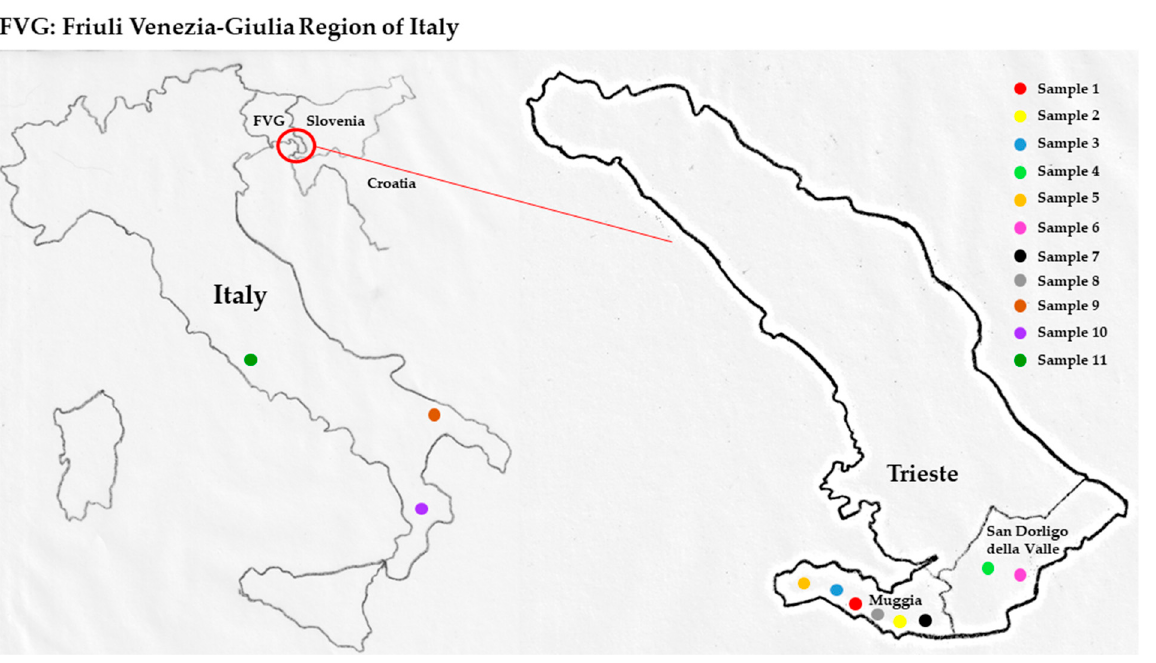
Figure 12. Olive oil samples’ geographical distribution. Table 4. Concentrations of compounds 7 – 10 in milligrams per kilogram of olive oil (mg/kg), as determined using q